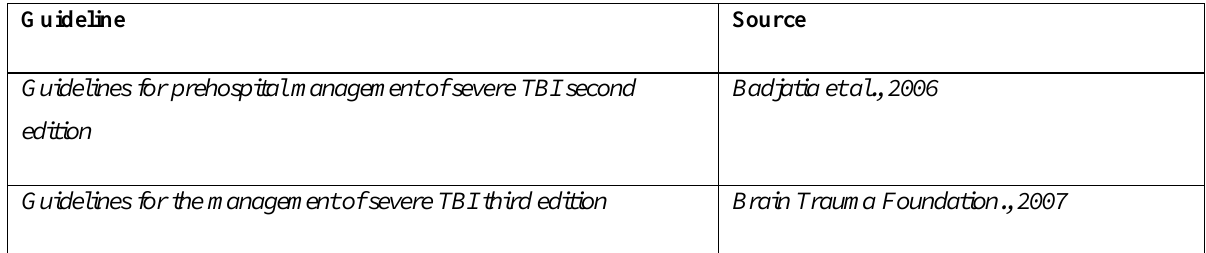
Table 3. Guidelines for the Management of